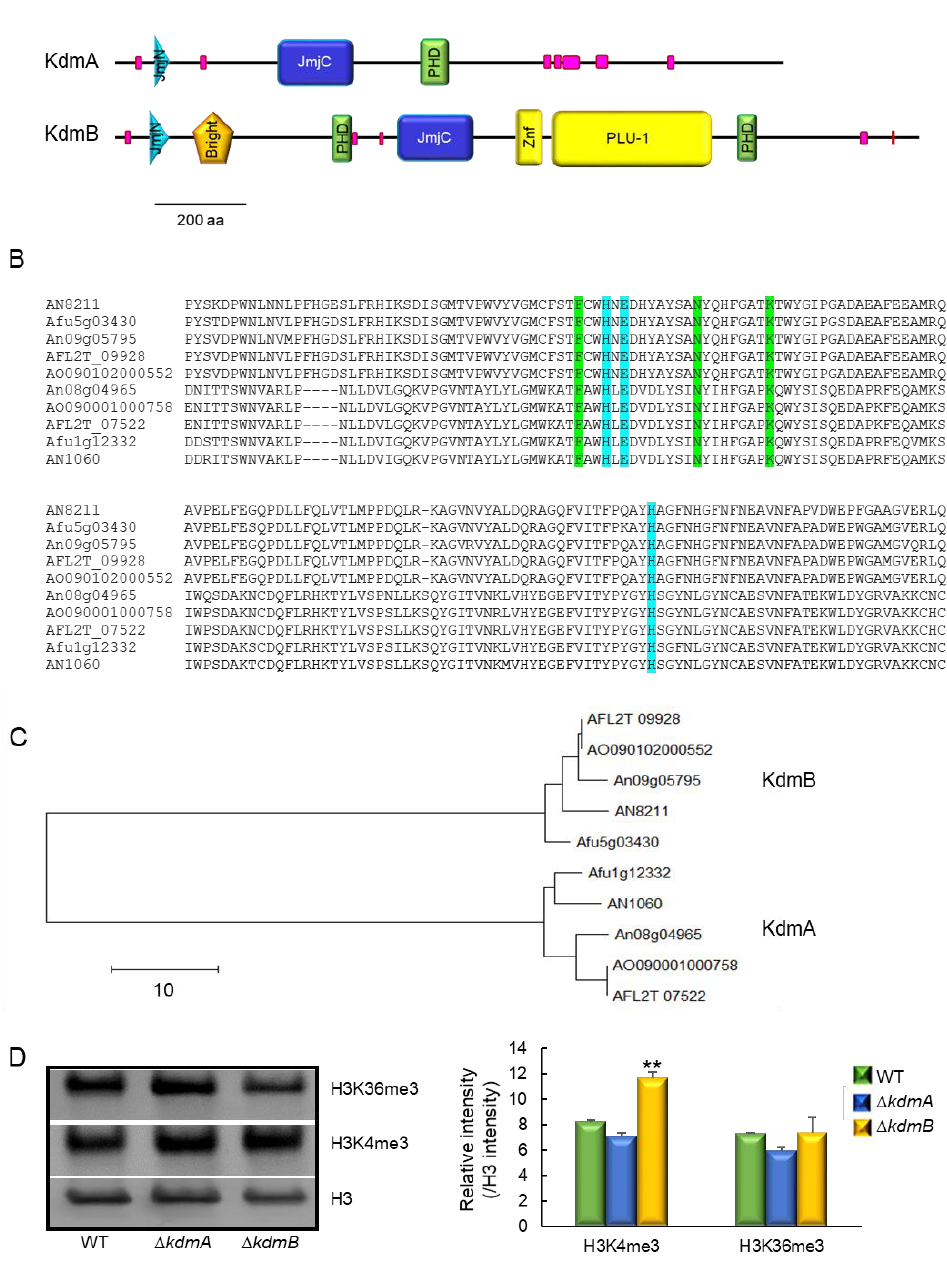
Figure 1. Molecular structures of KdmA and KdmB. ( A ) Schematic presentation of the domain struc- tures of the KdmA and KdmB proteins using SMART (http://smart.embl-heidelberg.de, accessed on 4 April 2021). ( B ) Multiple sequence alignment of the JmjC domains of demethylases from A. nidulans (AN), A. fumigatus (Afu), A. niger (An), A. flavus (AFL), and A. oryzae (AO). Conserved residues responsible for α -ketoglutarate and Fe (II) binding sites are marked in green and blue, respectively. ( C ) A phylogenetic tree of demethylase-like proteins in various Aspergillus species constructed based on the matrix of neighbor-joining distances between the JmjC domain sequences. ( D ) Western blot with antibody specific to histone H3, H3K4me3, and H3K36me3 antibodies. Relative intensities are shown below. Statistical significance of differences was assessed by Student’s t -test: ** p <